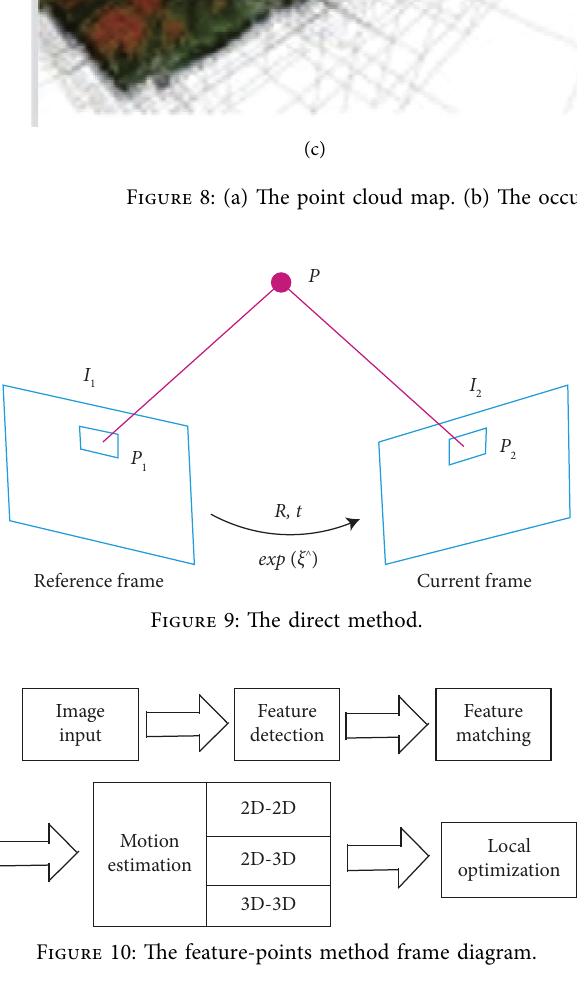
Figure 10: Te feature-points method frame algorithm (rBRIEF) and improved the scale invariance of the original FAST [68]. Te rBRIEF algorithm is proposed by using the exhaustive method to select points, which ensures rotation invariance. Te ORB-SLAM series makes good use